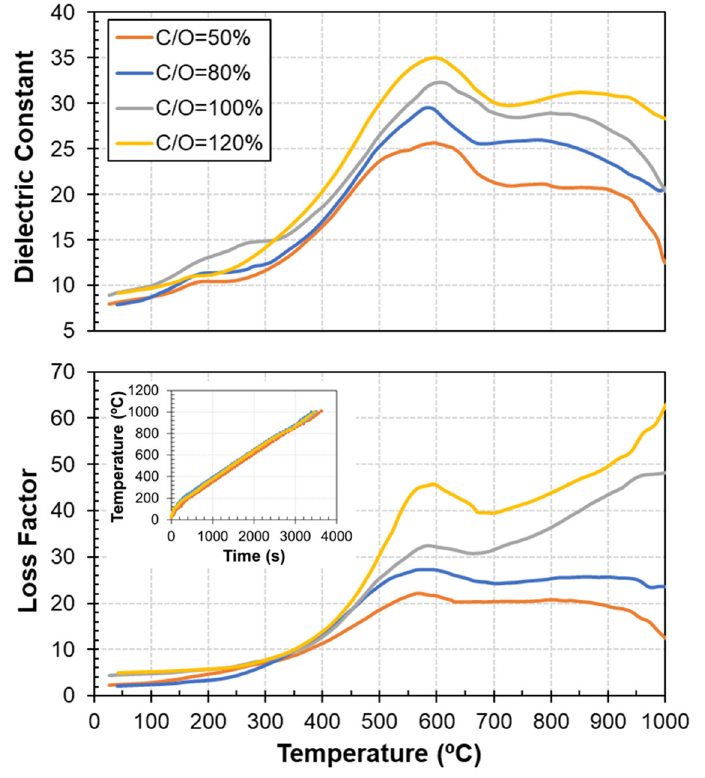
Figure 4. Dielectric properties of samples with different carbon content as a function of temperature.